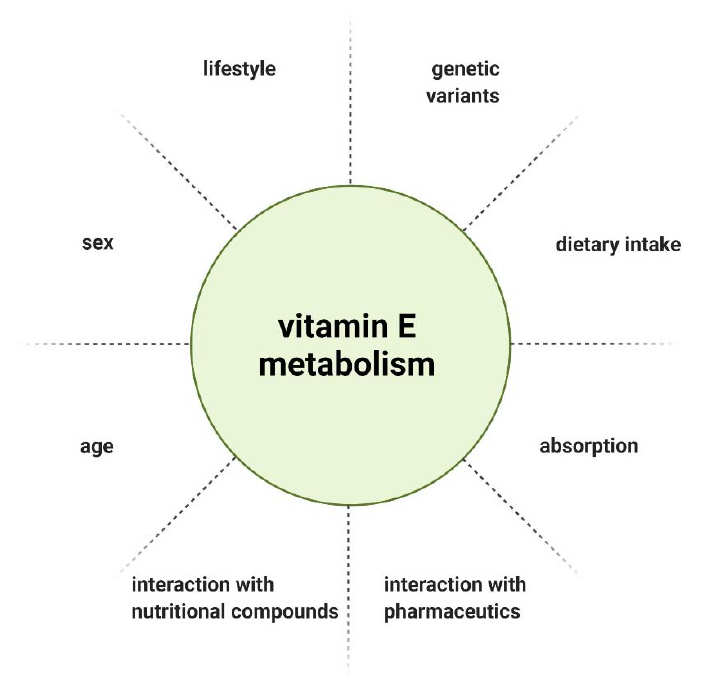
Figure 3. Factors influencing vitamin E metabolism.